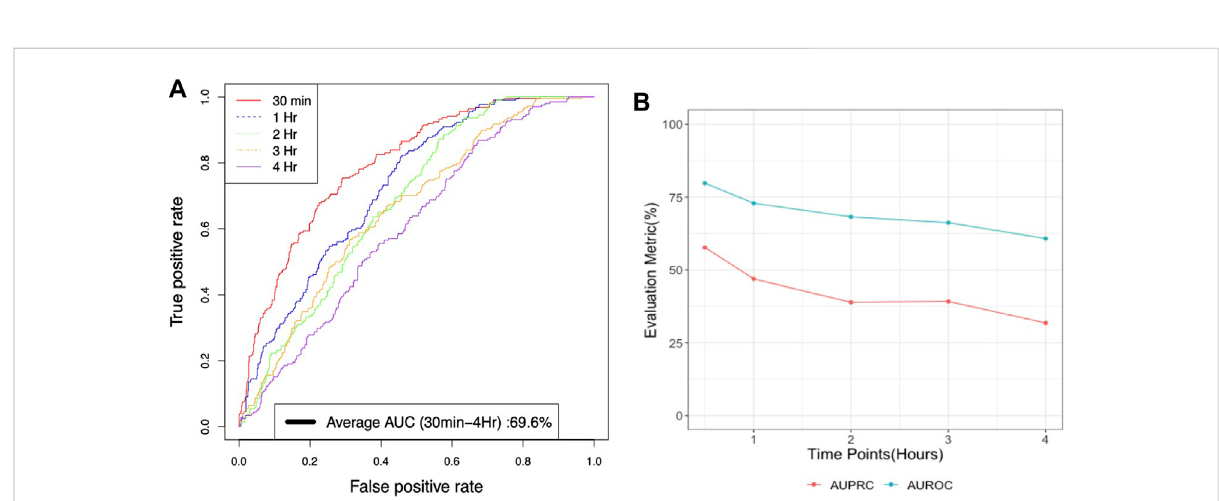
FIGURE 4 (A) Average AUROC performance for xgboost model with lead times or times before for prospective validation of Hypothermia in the next 30 min to 4 h (B) AUROC and AUPRC performance for xgboost model with lead times or times for prospective validation ofHypothermia inthe next 30 min to 4